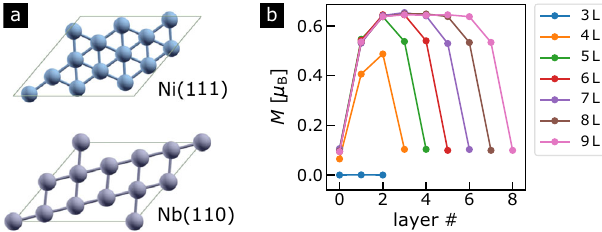
Fig. 5 Magnetization of Nb/Ni/Nb junction. a Top view of the Nb (110) and Ni(111) surface supercells used to build the Nb/Ni interfaces and the Nb(110)/Ni(111)/Nb(110) stacks shown in Fig. 1c. The surface supercell is de fi ned from two 2D vectors a 1 = [10.8, 0] Å and a 2 = [6.03, 7.11] Å with periodic boundary condition in the 2D plane. The corresponding reciprocal space de fi nes the 2D k ∥ vectors used in the calculations. Each atomic plane of Ni (Nb) contains 14 (10) atoms of Ni (Nb). b Magnetic moment pro fi le of Nb (110)/Ni(111)/Nb(110) junctions for different thicknesses of Ni (from 3 to 9 layers). The value of the moment is an average over the moments of the 14 Ni atoms in each atomic plane. Note the magnetic dead layer at the Nb/Ni interfaces and that all moments vanish for the shortest junction made of 3 layers of